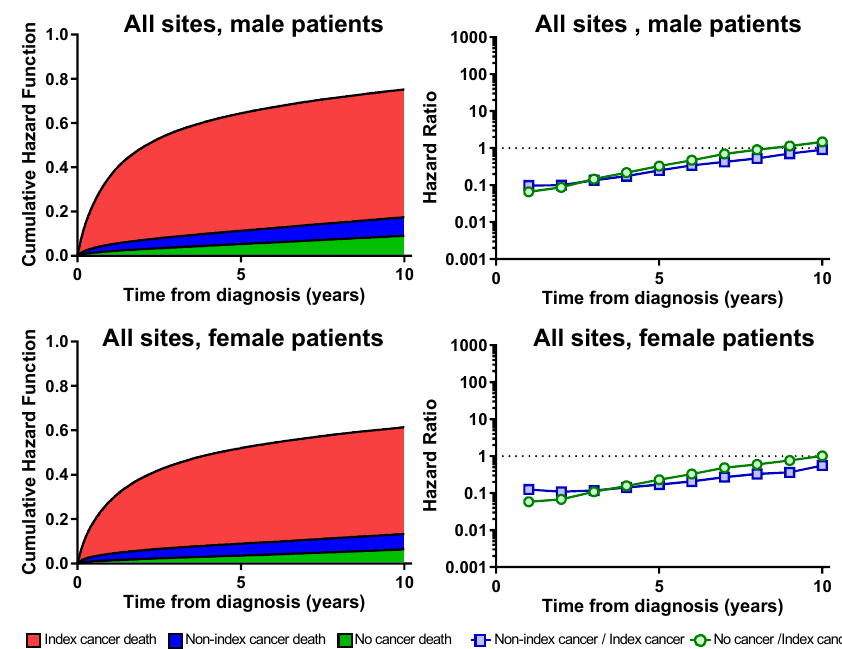
Figure 1. Cumulative hazard rate and hazard ratio by cause of death (all sites). The red area shows the index cancer death, the blue area shows the other cancer deaths, the green area shows the non-cancer deaths, and the other white area shows the cumulative survival rate.